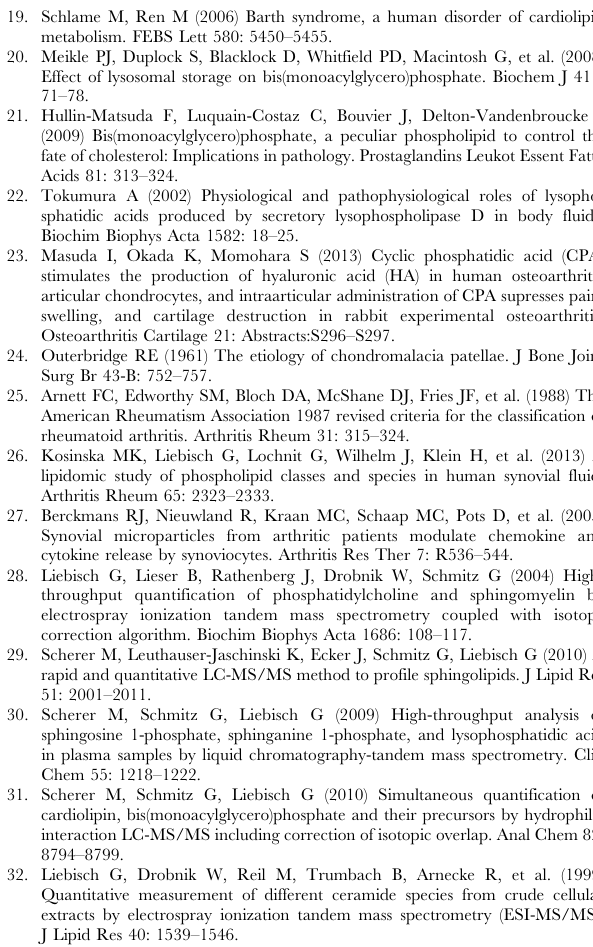
Figure S3 Concentrations of lipids in human synovial fluid as a function of the age of patients with rheumatoid arthritis. Lipids were determined by electrospray ionization tandem mass spectrometry (ESI-MS/MS) or liquid chromatogra- phy coupled with tandem mass spectrometry (LC-MS/MS) as outlined in Material and Methods . Values are displayed as a scatterplot of the concentration of each lipid class and species by age of donors. ( A ): Lipid classes, ( B ): Lipid species. SM- sphingomyelin, Cer-ceramide, HexCer-hexosylceramide (most